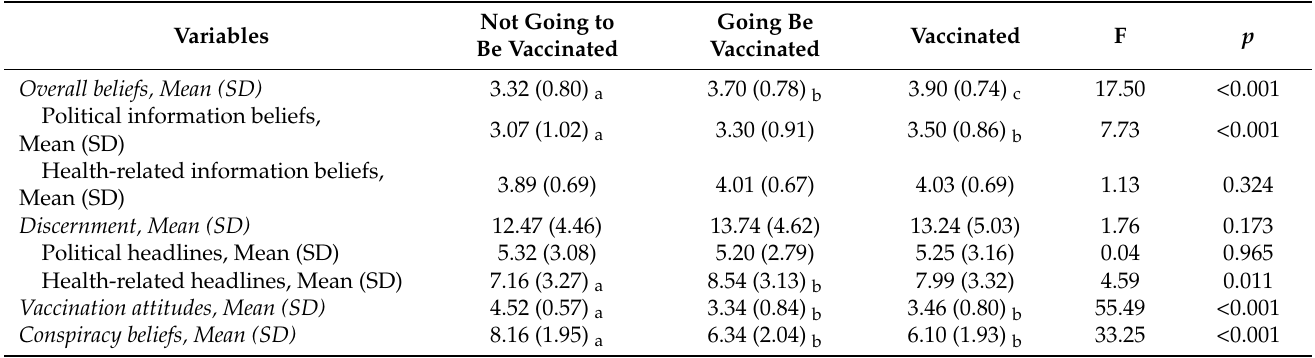
Table 1. Differences between the means and standard deviations of variables used in models between vaccination